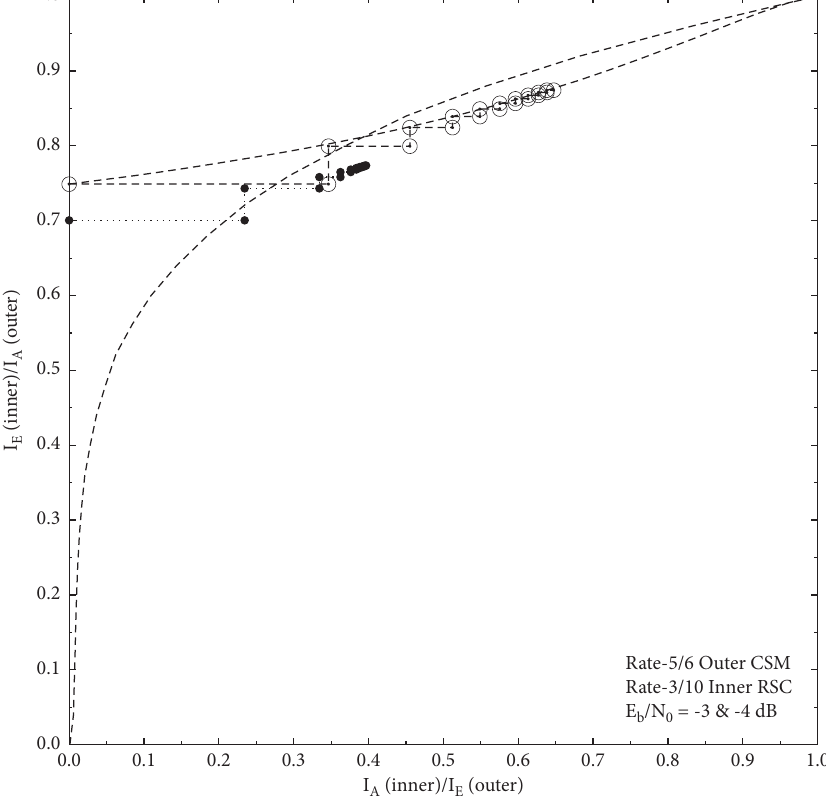
Figure 10: EXIT chart curves and decoding trajectories for Rate-5/6 CSM ( Mapping-I )